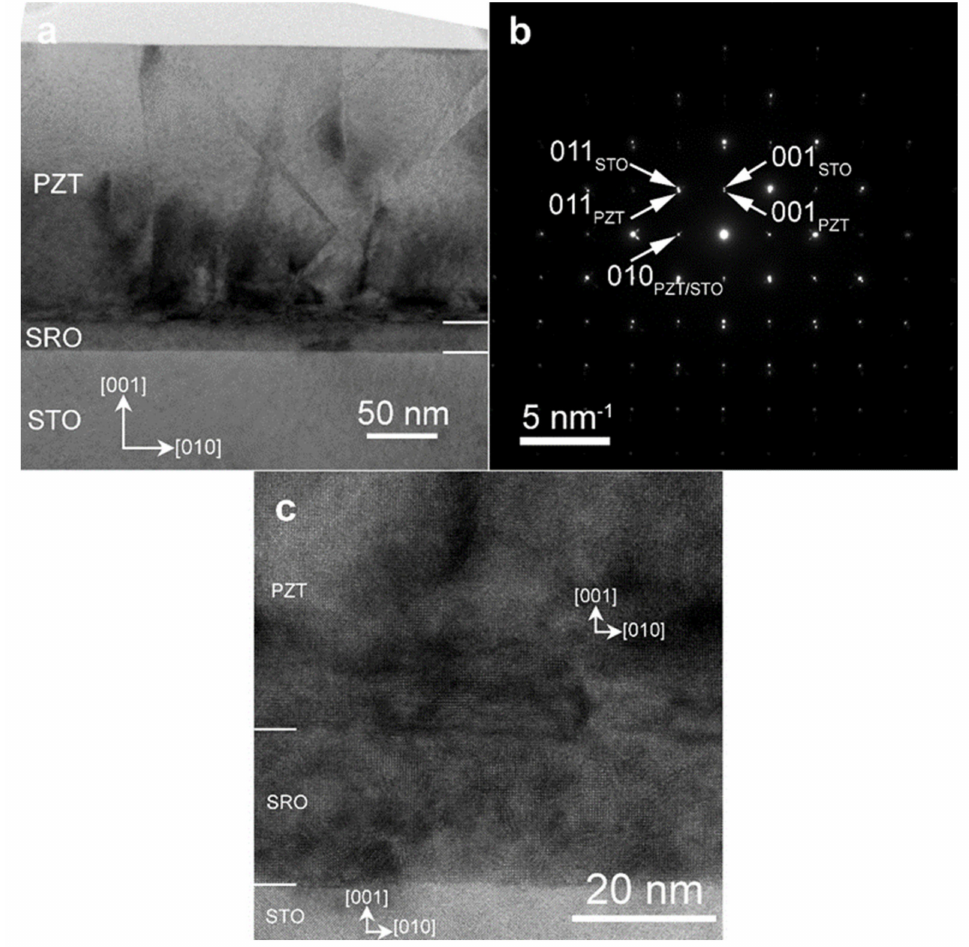
Figure 1. ( a ) TEM image at low magnification of the PZT/SRO/STO structure and ( b ) the correspond- ing SAED pattern from an area which includes both the substrate and the thin films, ( c ) HRTEM image of the SRO/STO and SRO/PZT